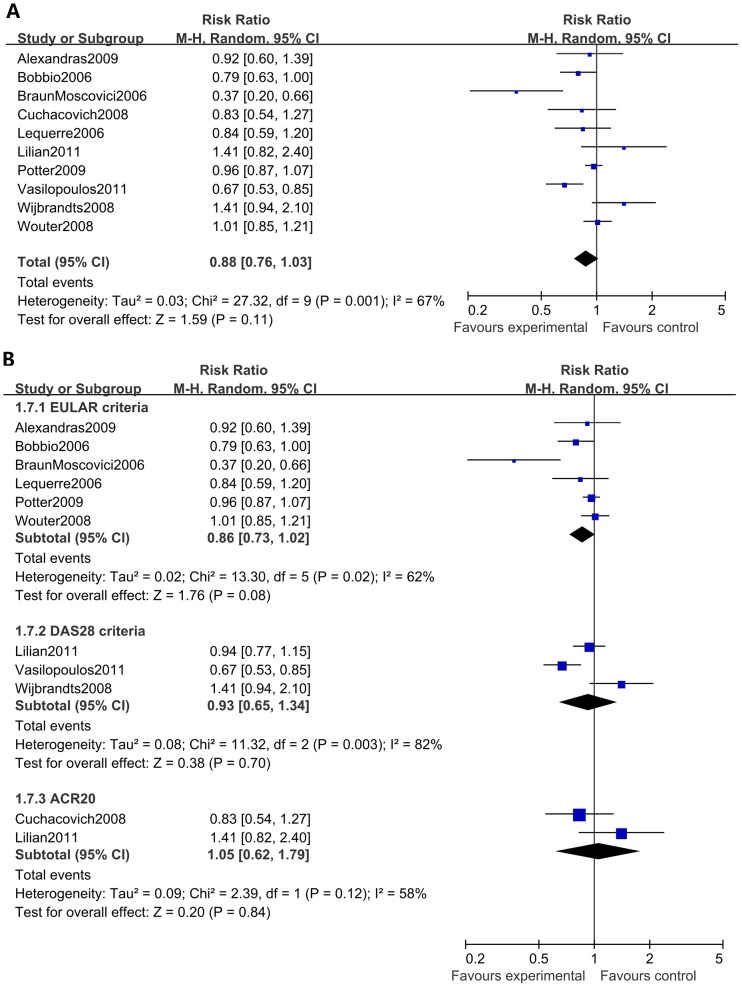
Forest graphs of the meta-analysis of anti-CCP antibody status and response to anti-TNFα agents.The overall analysis of anti-CCP antibody status showed a pooled RR of 0.88 (95% CI: 0.76–1.03, p = 0.11) and an I2 of 67%. Subgroup analyses on different response criteria revealed no significant differences.